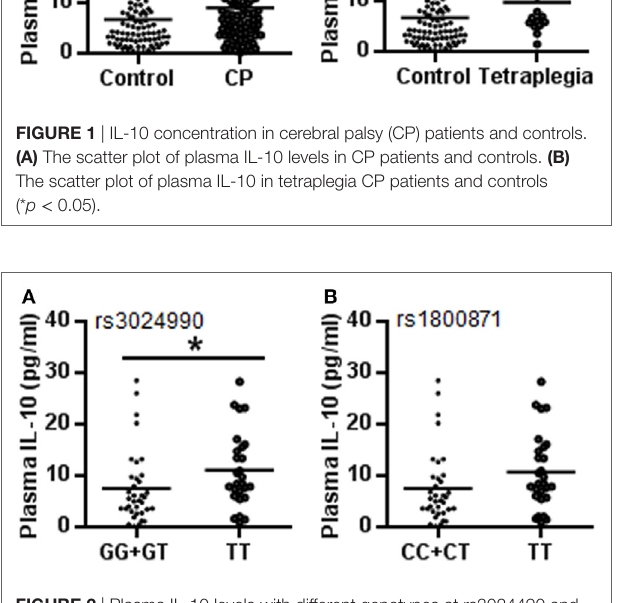
FigUre 2 | Plasma IL-10 levels with different genotypes at rs3024490 and rs1800871. (a) IL-10 levels with different genotypes at rs3024490. (B) IL-10 levels with different genotypes at rs1800871. Each dot represents one patient (* p < 0.05).